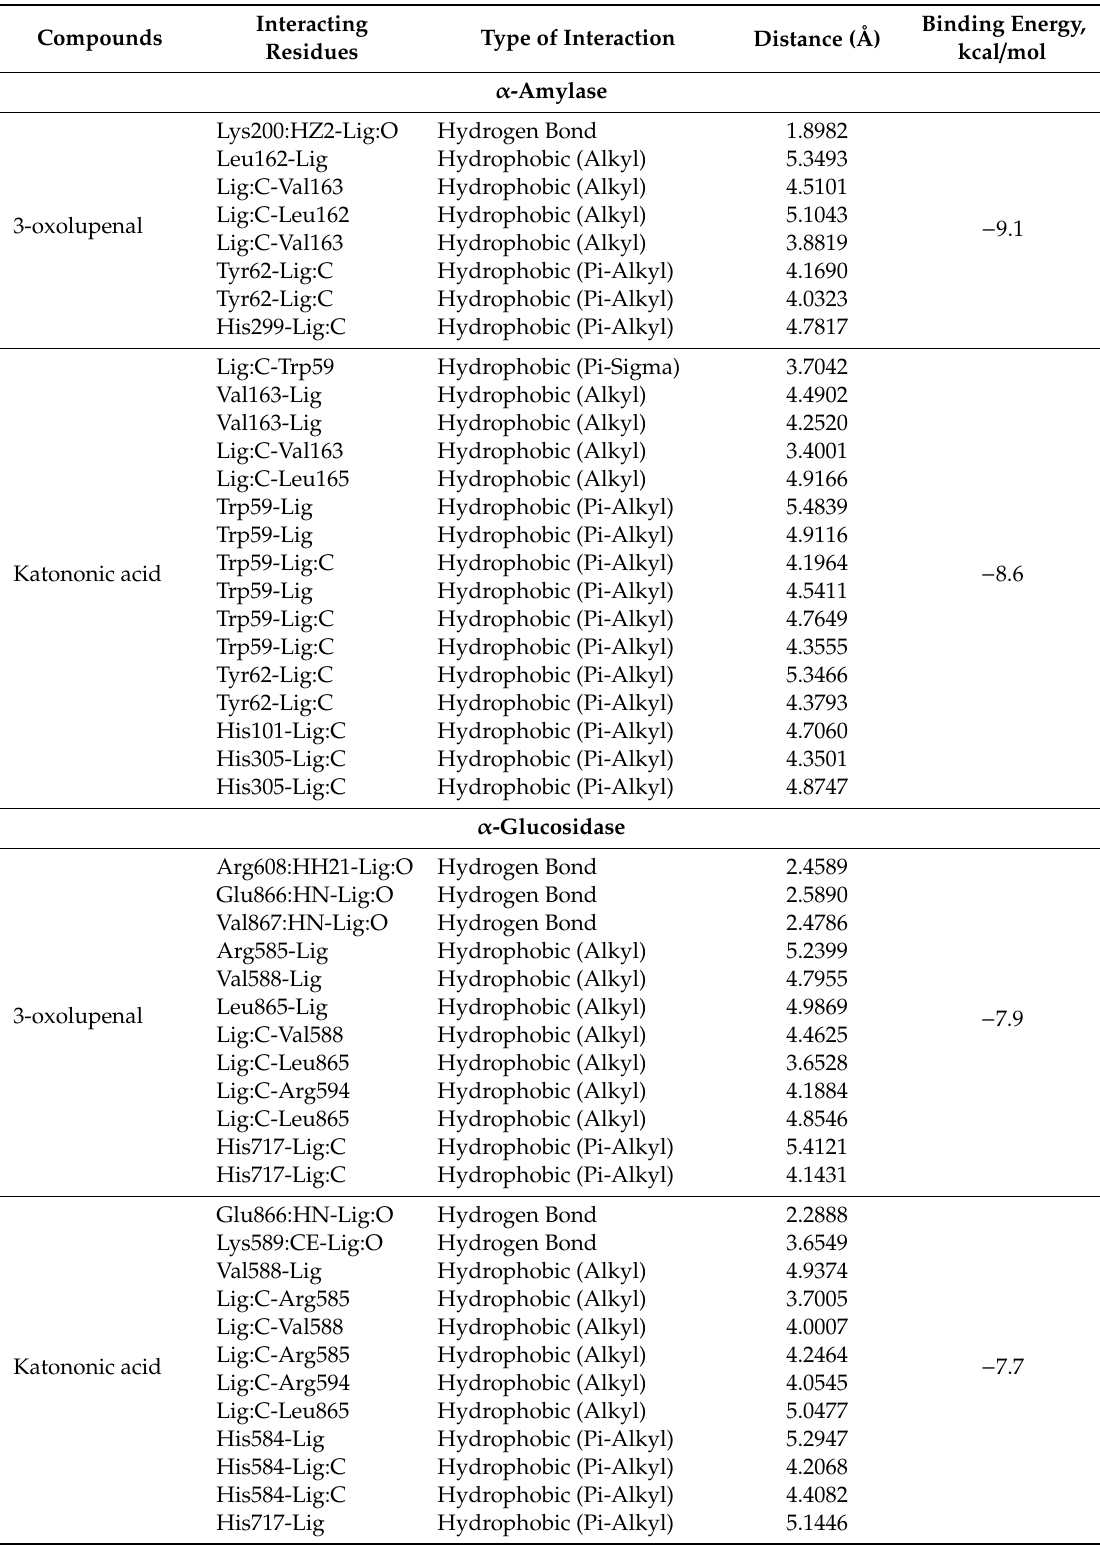
Table 4. Molecular docking parameters for 3-oxolupenal and katononic acid interaction with α -amylase and α